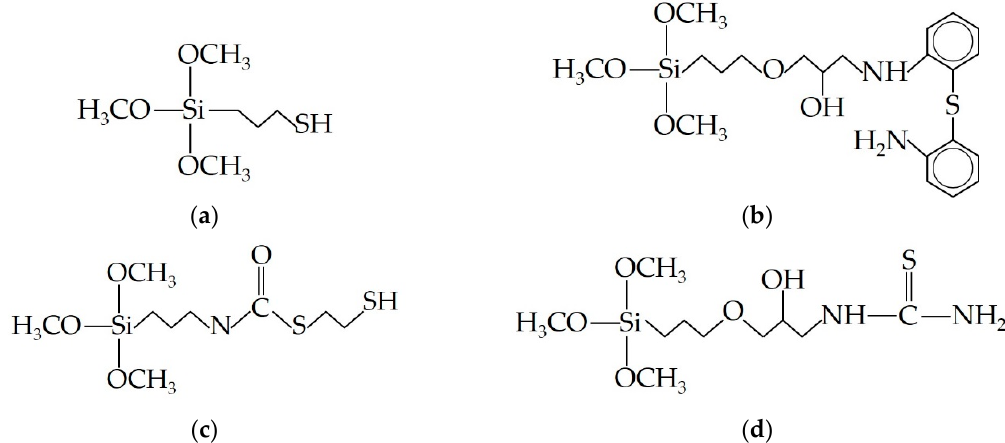
Figure 5. Silylating agents used by: ( a ) Fonseca et al. (3-mercaptopropyltrimethoxisilane); ( b ) Moscofian et al. (silane containing a 2-aminophenyldisulfide molecule); ( c ) Badshah et al. (thiocarbamate organosilane); and ( d ) Dey et al. (organosilane derived from 3-glycidoxypropryltrimethoxysilane and thiourea) in their sol-gel synthesis of phyllosilicates.